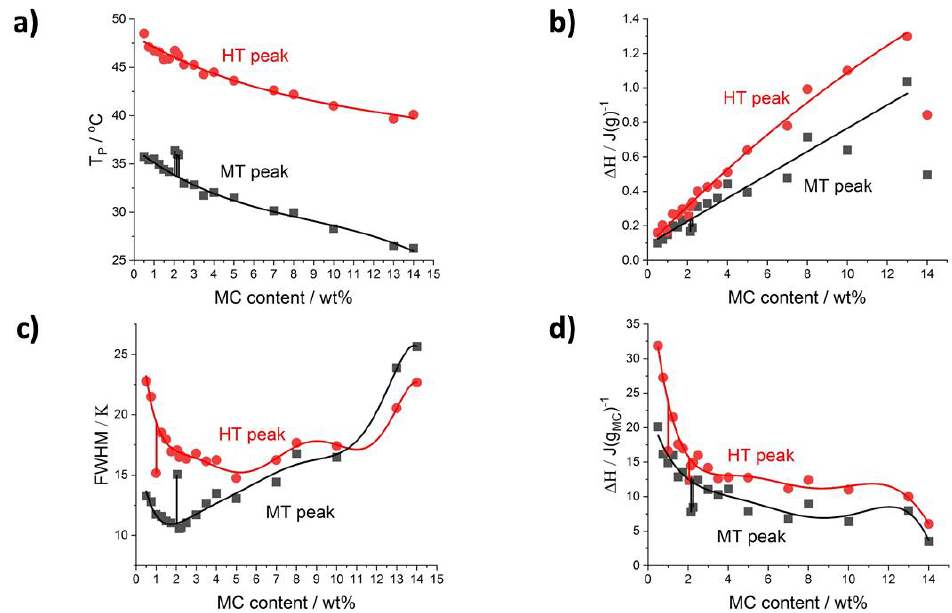
Figure 5. Deconvolution results for cooling scans as a function of MC content: ( a ) peaks’ temperature position, ( b ) peak’s transition heat normalized to sample mass, ( c ) peaks’ full with at half maximum, ( d ) peak’s heat normalized to MC mass.